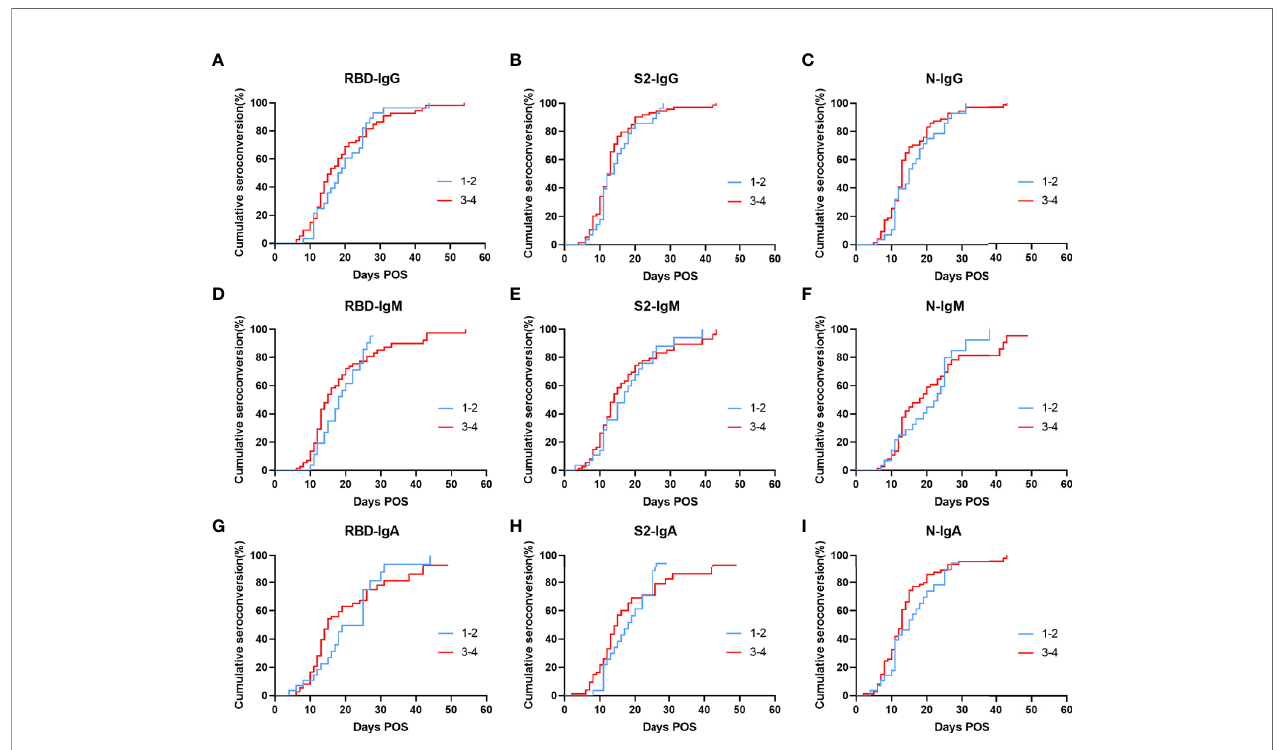
FIGURE 5 | Cumulative seroconversion rates of RBD, S2, and N speci fi c IgG (A – C) , IgM (D – F) , and IgA (G – I) in patients with different clinical types. Patients were divided into two groups, including low severity patients (blue) with mild and moderate severity and high severity patients (red) with severe and critically ill severity. P values were determined using the Log-Rank test. All P values in this fi gure are greater than 0.05. Ig, immunoglobulin; N, nucleocapsid protein; RBD, receptor-binding domain; S,